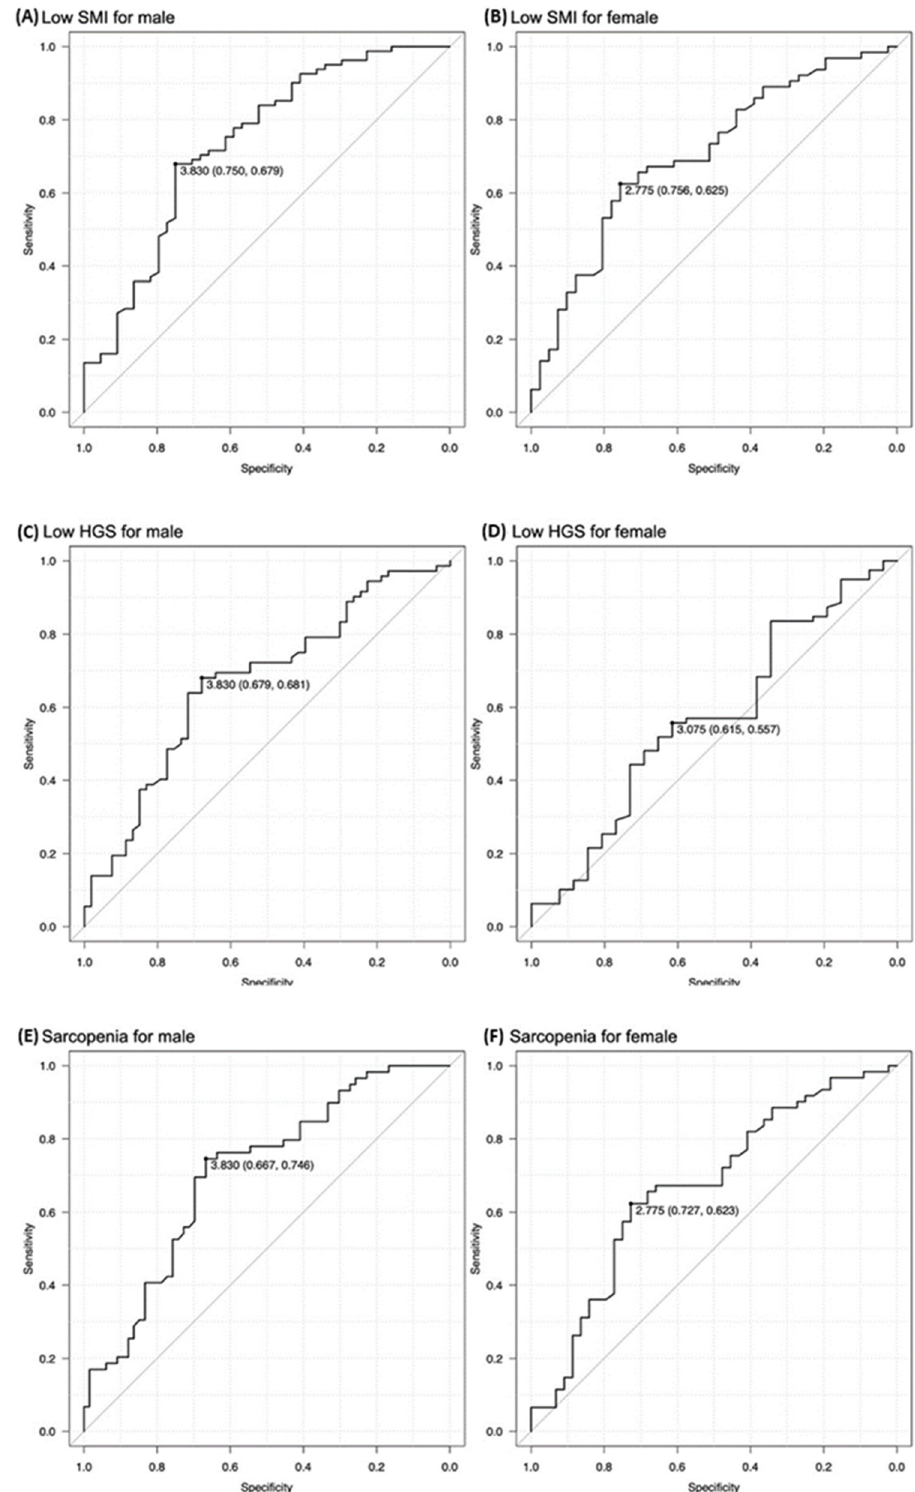
Figure 1. The temporal muscle thickness (TMT) cutoff values for identifying low skeletal muscle index (SMI), low hand grip strength (HGS), and sarcopenia. The TMT cutoff values for identifying low SMI were 3.83 mm for men and 2.78 mm for women ( A , B , respectively). The TMT cutoff values for identifying low HGS were 3.83 mm for men and 3.08 mm for women ( C , D , respectively). The TMT cutoff values for identifying sarcopenia were 3.83 mm for men and 2.78 mm for women ( E , F , respectively).